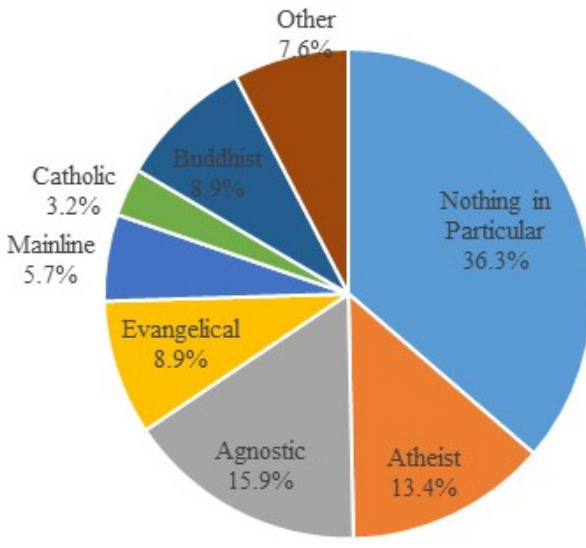
Figure 1. Religious Affiliation of Young Chinese